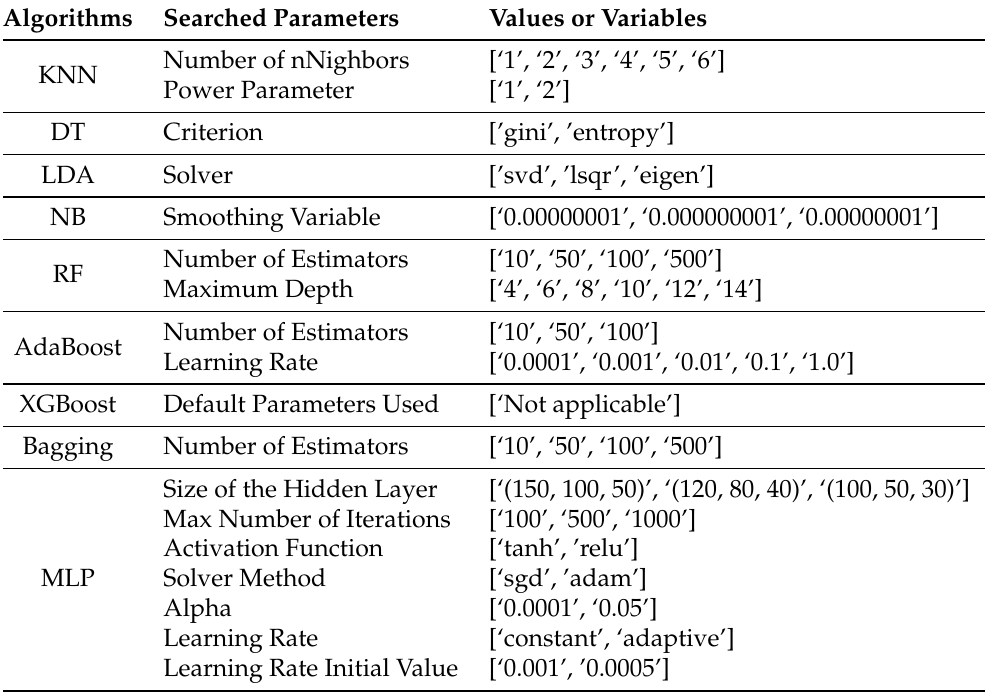
Table 1. Searched hyper-parameters during the training of the smoke classification